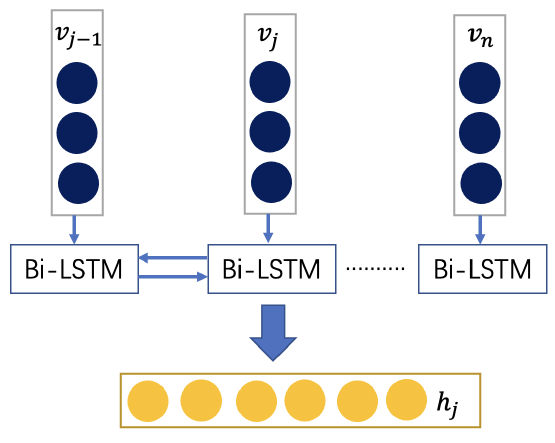
Figure 8. The schematic of